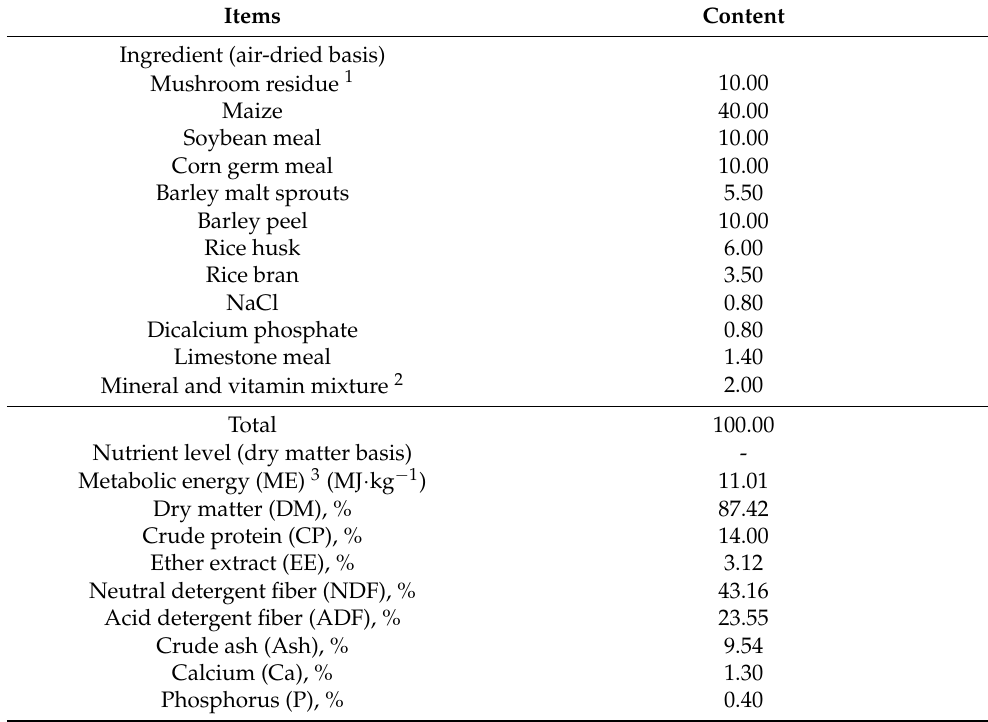
Table 1. Composition and nutrient levels of